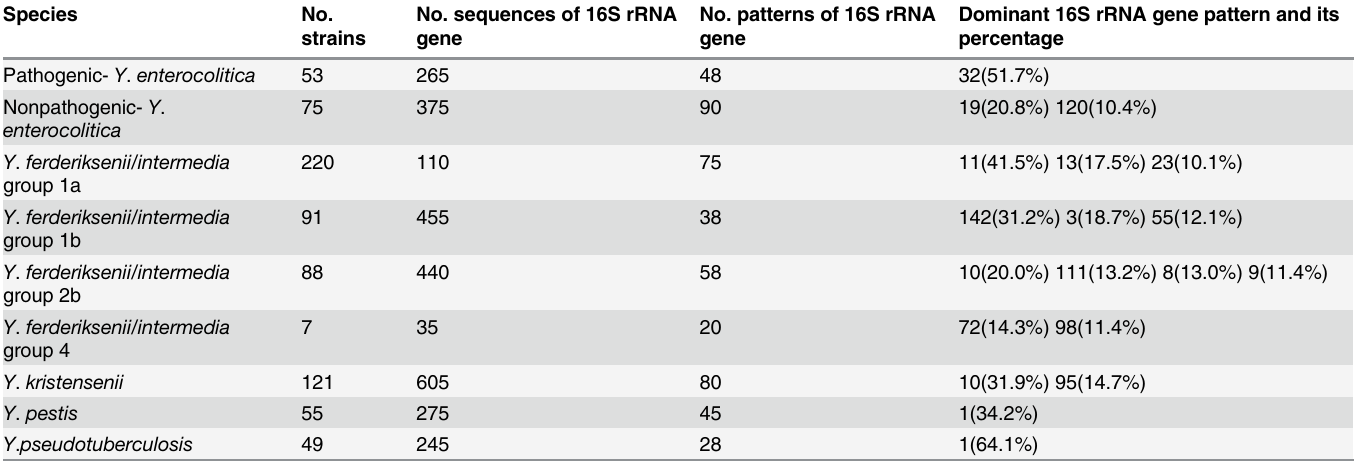
Table 4. The dominant patterns of the 16S rRNA genes in each Yersinia